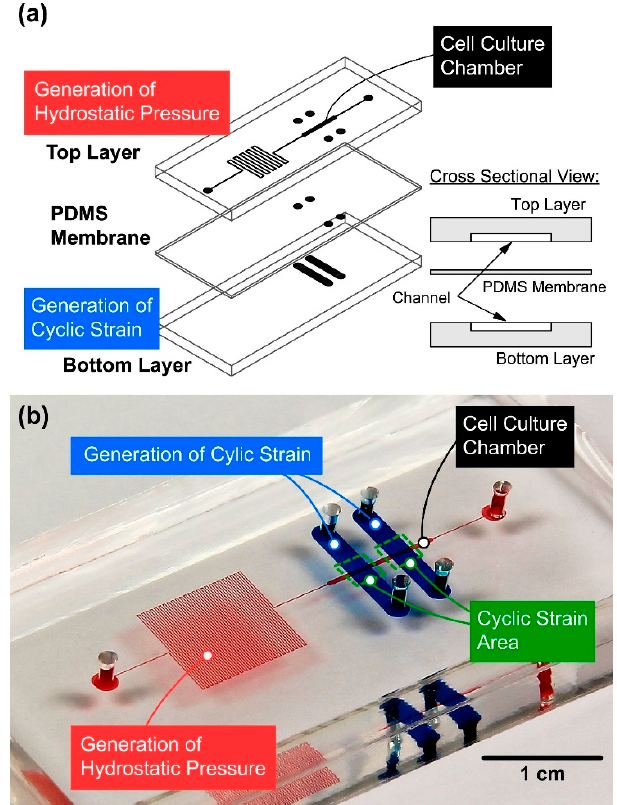
Figure 1. ( a ) Schematic of the designed microfluidic device to generate physical stimulations for lung epithelial cell surfactant protein expression studies. ( b ) Photo the fabricated device filled with colored food dyes (red: cell culture channel; blue: actuation channel.